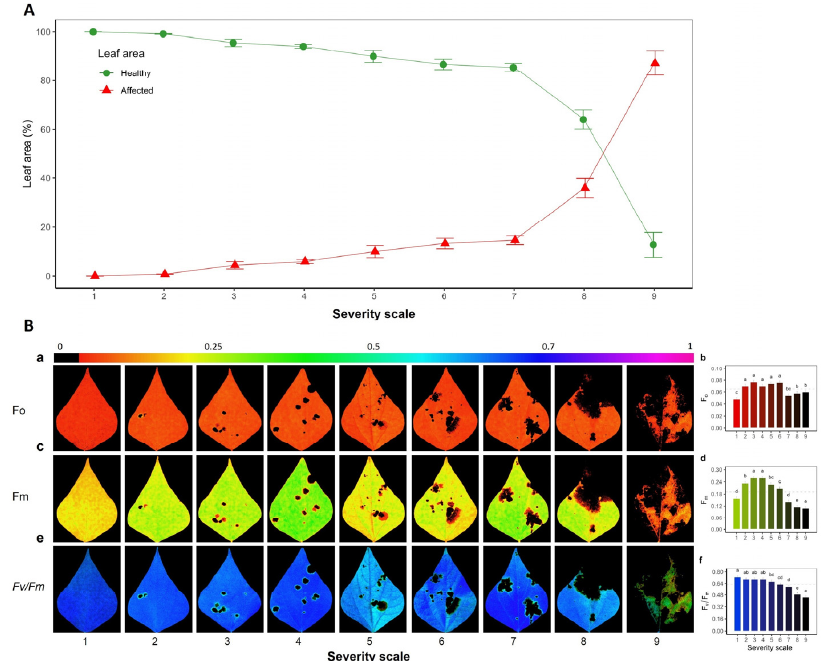
Figure 1. Severity of web blight on common bean leaves. ( A ) Area (%) of healthy and affected leaves according to the severity scale; the x -axis is related to the severity scale of 1 to 9, proposed by Schoonhoven and Pastor-Corrales (1987). ( B ) Chlorophyll fluorescence variables quantified during the dark adaptation phase: ( a , b ) initial fluorescence (F 0 ); ( c , d ) maximum fluorescence images (F m ); ( e , f ) PSII maximum quantum efficiency (F v /F m ) images; ( b , d , f ) bar graph with mean values for each variable, respectively. The color gradient bar shown from violet to red or black indicates the maximum and minimum value of each variable, respectively, where healthy zones range from blue to violet, and disease affected zones range from green to black color. a,b,c,d,e : Different letters within each severity scale in ( b , d , f ) subfigures indicate statistical differences according to Fisher’s LSD test of means ( p < 0.05). Results include the mean ± SE of 27 leaves at each severity scale level of 1 to